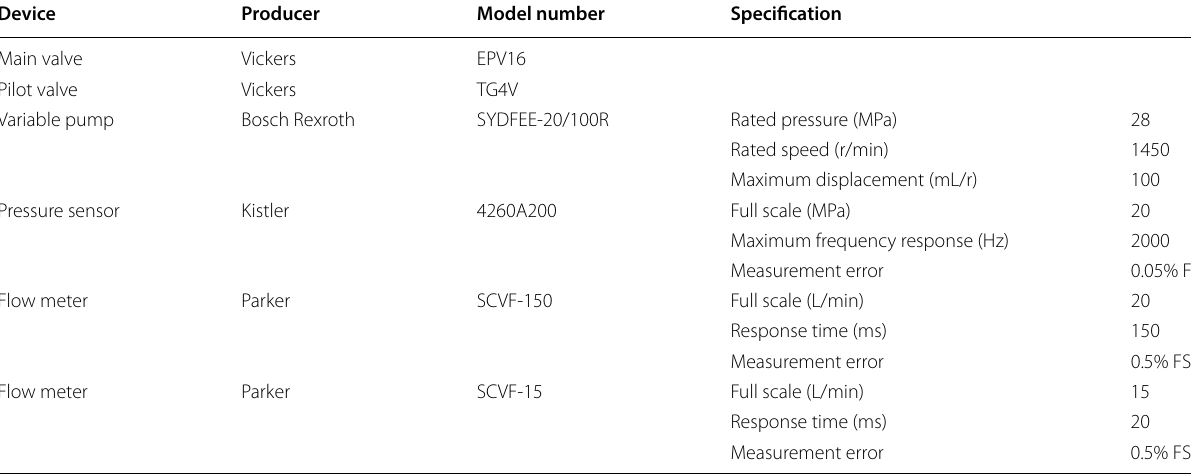
Table 1 Specifications of experimental setup